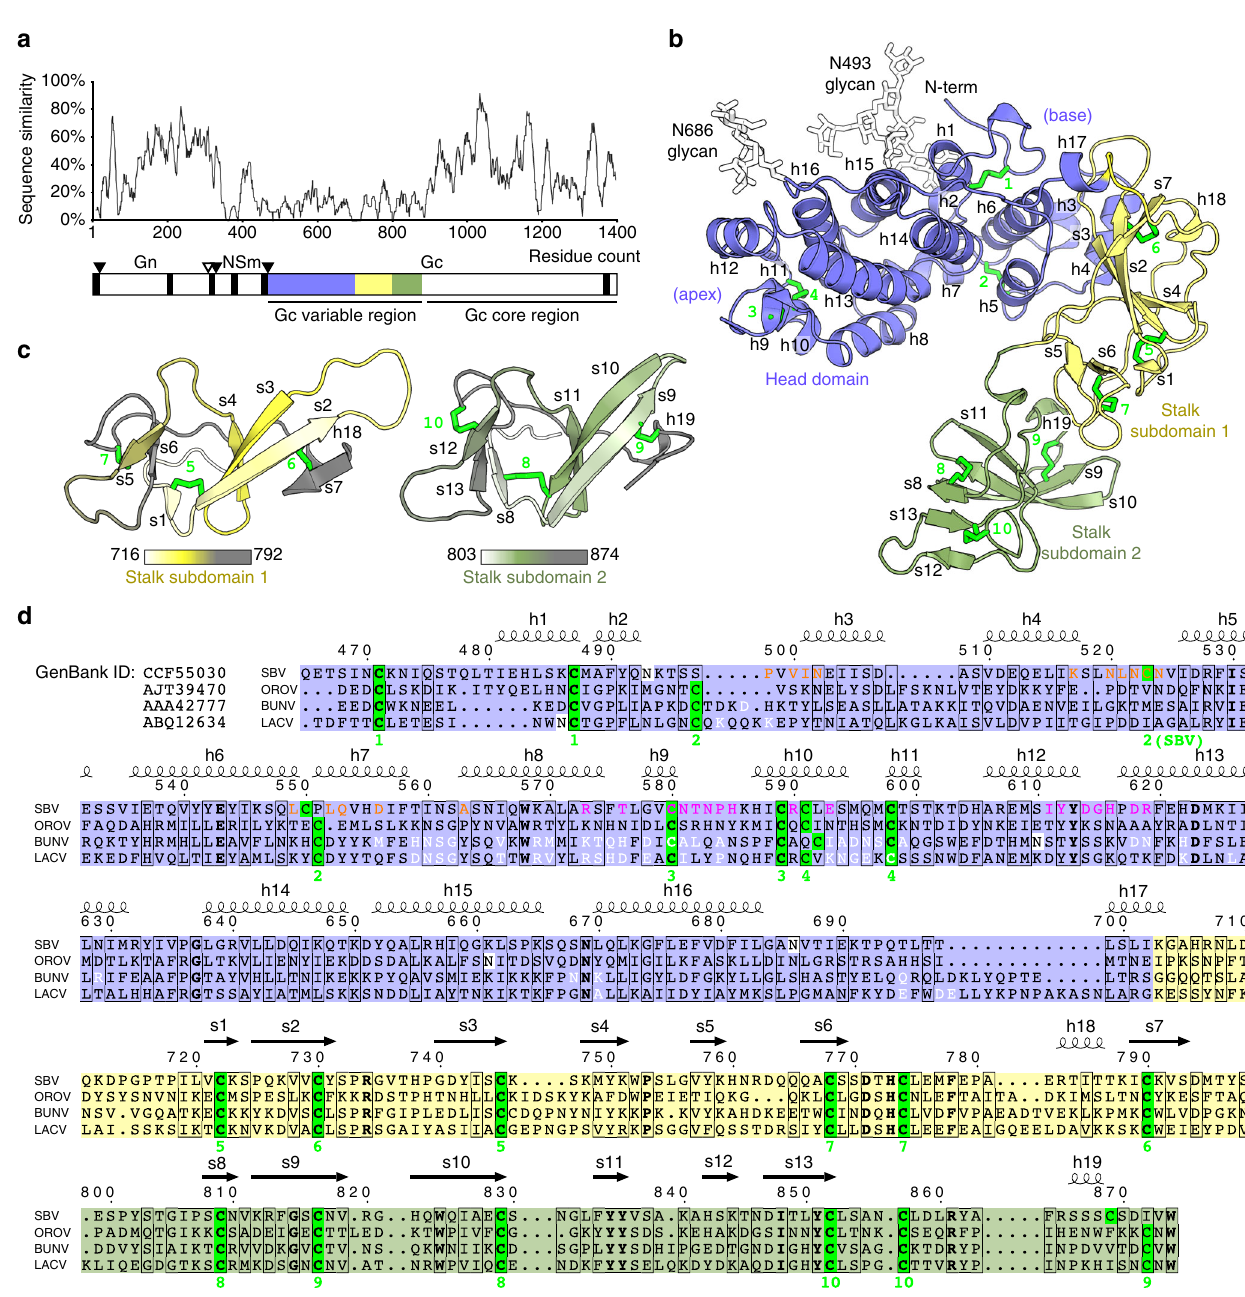
Fig. 1 The N-terminal variable half of OBV Gc is composed of two domains. a Relative amino acid sequence similarity across 100 OBVs over the glycoprotein precursor. Putative transmembrane regions are indicated as black bars. Three secretion signal peptidase cleavage sites are indicated as fi lled triangles and an additional protease cleavage site is indicated as an empty triangle 52 . b Crystal structure of the variable region of SBV Gc. The head domain is shown in blue, and the two stalk subdomains are shown in yellow and green. The two carbohydrate chains were not originally part of the structure of this deglycosylated protein, and were added to this illustration based on the crystal structure of the SBV head domain in complex with scFv 1C11 (Fig. 5 and Supplementary Fig. 1). Disul fi de bonds are shown in bright green and are numbered sequentially. Secondary-structure elements are labeled with h for helices and s for β strands. c The two stalk subdomains are aligned to each other for structural comparison. They are colored in a gradient from white at their N-terminus to gray at their C-terminus. d Sequence alignment of the variable region of Gc from SBV, OROV, BUNV, and LACV. Secondary-structure elements and sequence numbering of SBV are given above the alignment; disul fi de bonds are numbered sequentially below the alignment. Strictly conserved residues are boldfaced, similar residues are boxed. Cysteines involved in disul fi de bonds are highlighted on bright green background; N -glycosylation sites are highlighted on white background. Residues at the epitopes of mAbs 1C11 and 4B6 are indicated in magenta and orange font, respectively. Residues at the trimer interfaces of BUNV and LACV are indicated in white font. The sequences of the two stalk subdomains are aligned to each other in the last two rows of the